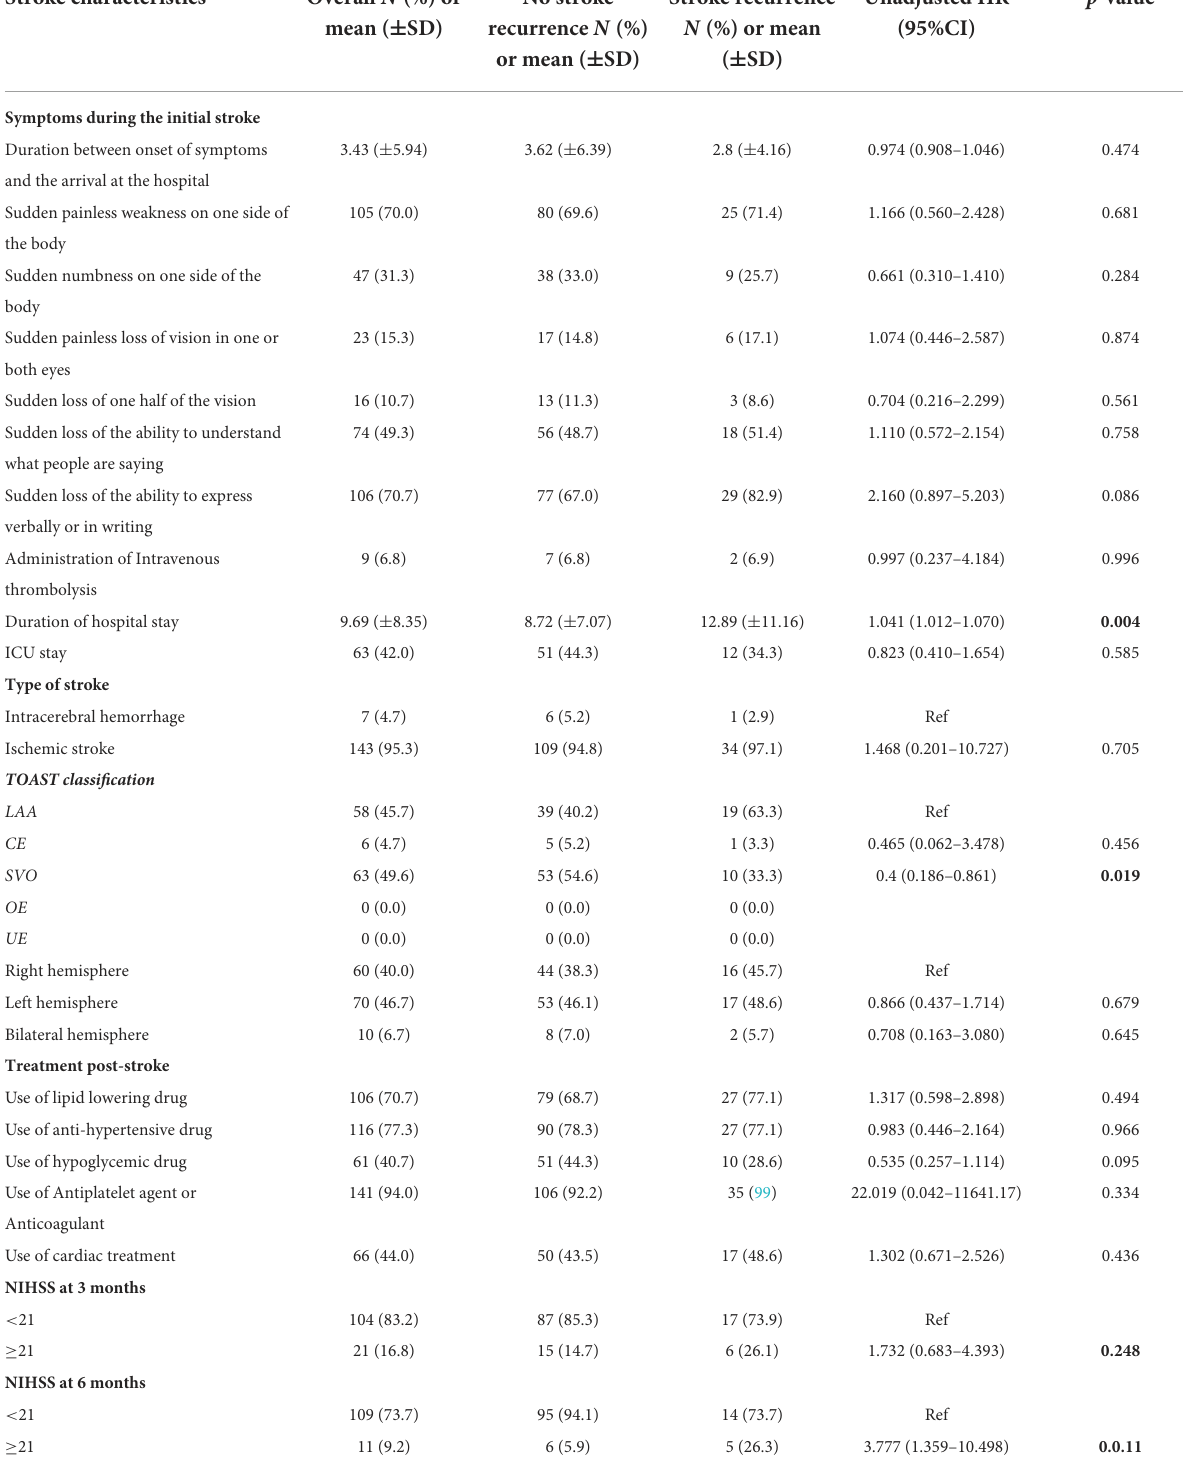
TABLE 4 The association of stroke in-hospital course and complications post-stroke with 1-year stroke recurrence using Cox Proportional Hazard regression univariate analysis. Stroke